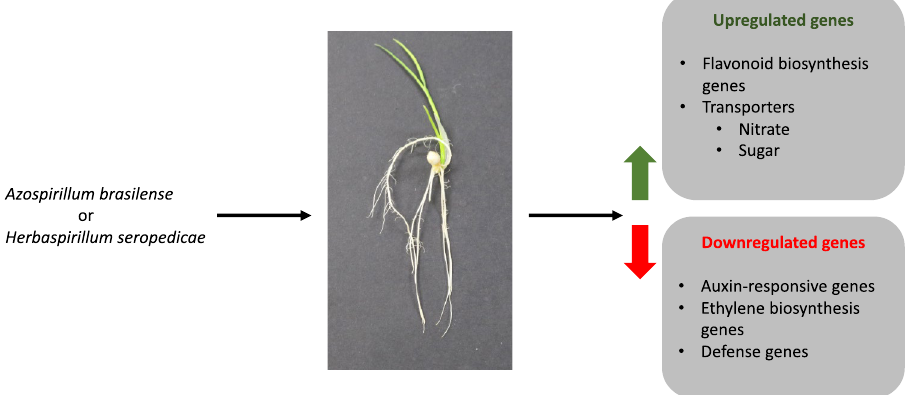
Figure 6. A model summarizing the common trends in gene expression changes observed in rice roots during associations with plant growth-promoting bacteria, Azospirillum brasilense and Herbaspirillum seropedicae